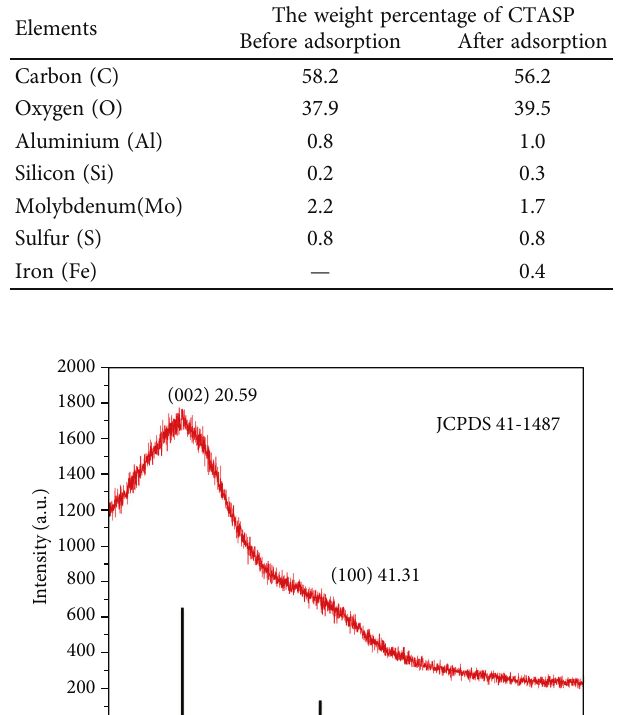
Table 1: EDS spectra of ARS dye for before and after adsorption. Elements